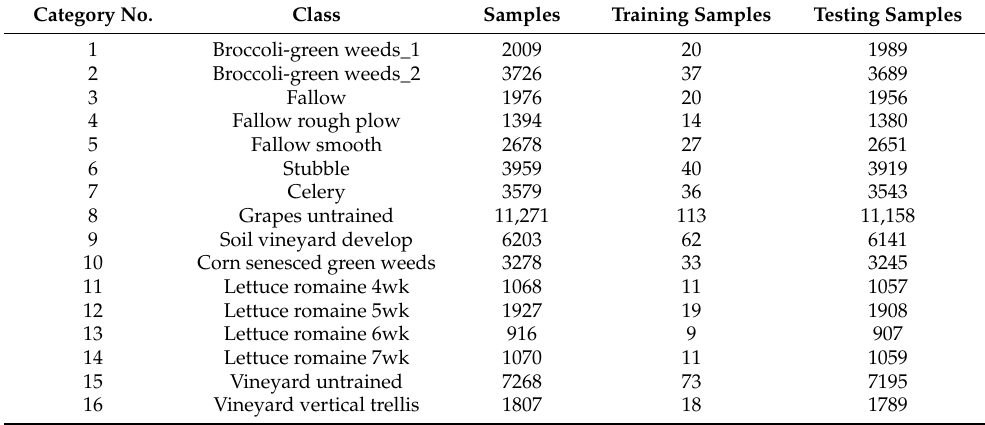
Table 1. The SA dataset. Category